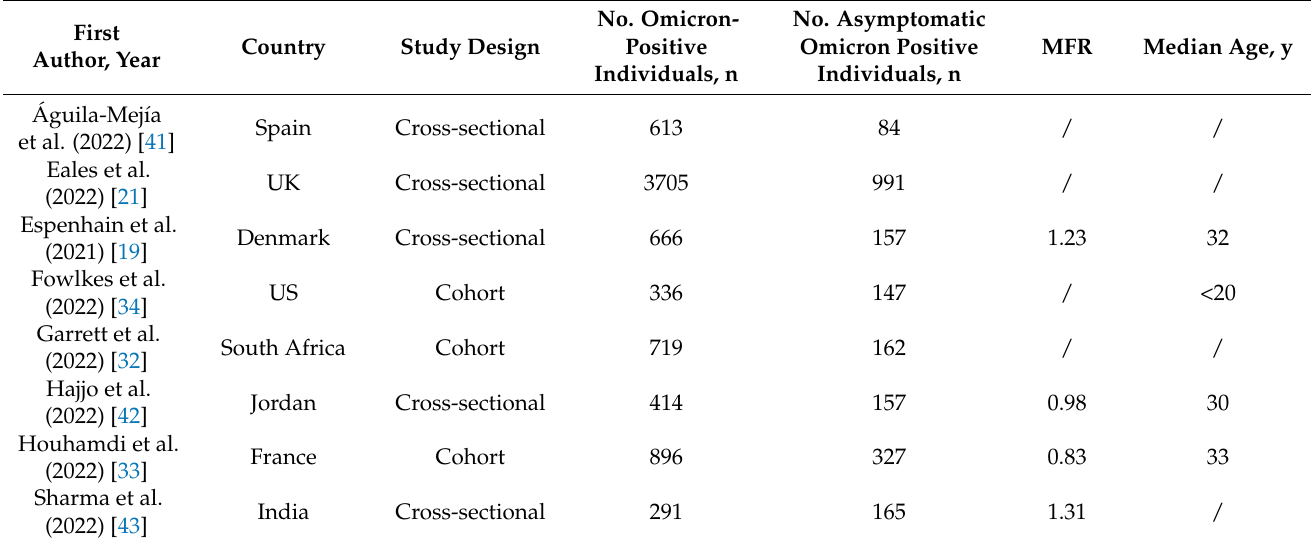
Figure 1. Flowchart of the study selection. Table 1. Characteristics of the Studies Included in the Systematic Review and Meta-analysis.